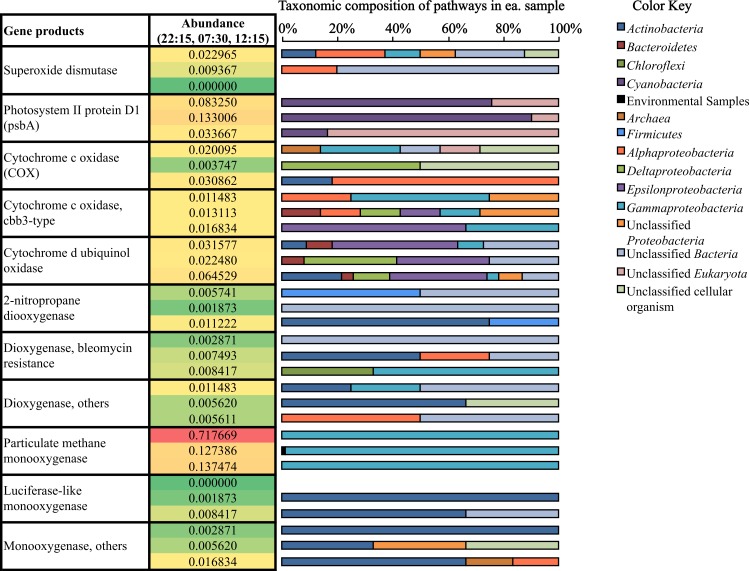
Relative abundance and taxonomic composition of mRNA transcripts involved in O2 production and utilization.Rel. abundance values shown are the % of potential mRNA transcripts from each sample, 22:15 (top of ea. box). 07:30 (middle), and 12:15 (bottom). The color scale ranks each gene from least abundant (green) to most abundant (red).